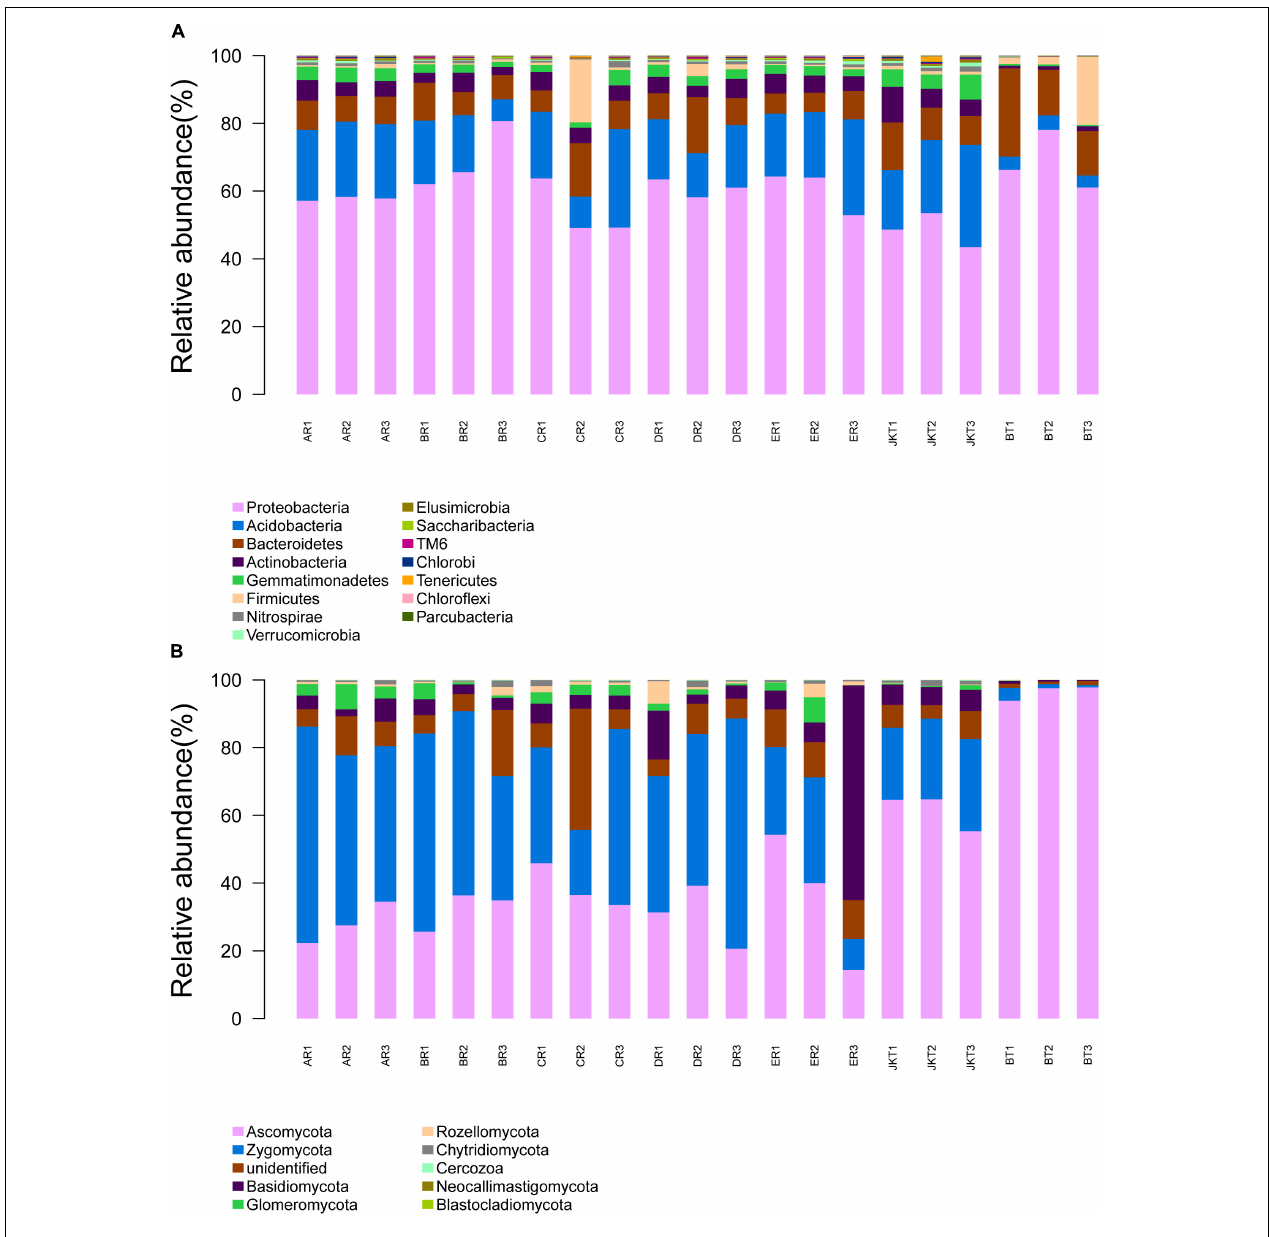
FIGURE 5 | Relative abundance at the phylum level. (A) Relative abundance at the phylum level in bacterial communities. (B) Relative abundance at the phylum level in fungal communities. Based on the species annotation results, we chose to examine the distribution of relative species abundance among the top-ranked phyla; the relative abundance distribution of the top 15 species (A) and the top 10 species (B) are shown. Each soil sample all collected from three replicate